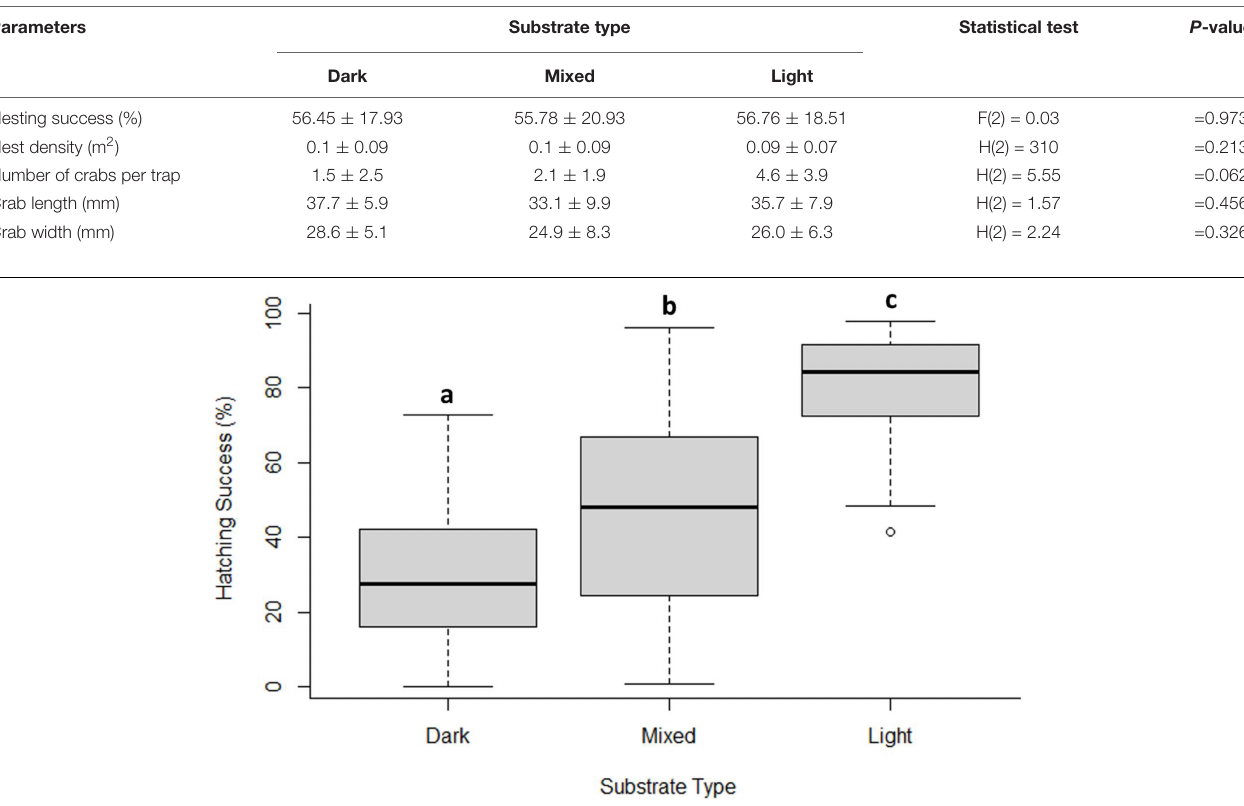
TABLE 1 | Nesting success, nest density, and crab biometric measurements among the three types of substrates on 14 beaches close to each other (5 in dark sand, 5 in mixed sand, and 4 in light sand) on the east coast of the island of Maio ( Figure 1 ).